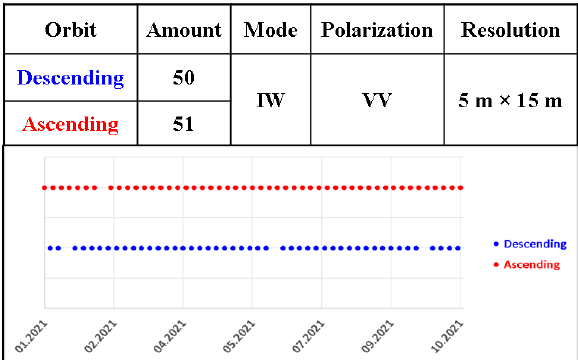
Figure 11. Ascending and descending Sentinel-1 images used for test in underground mine in Lędziny , Poland (owned by